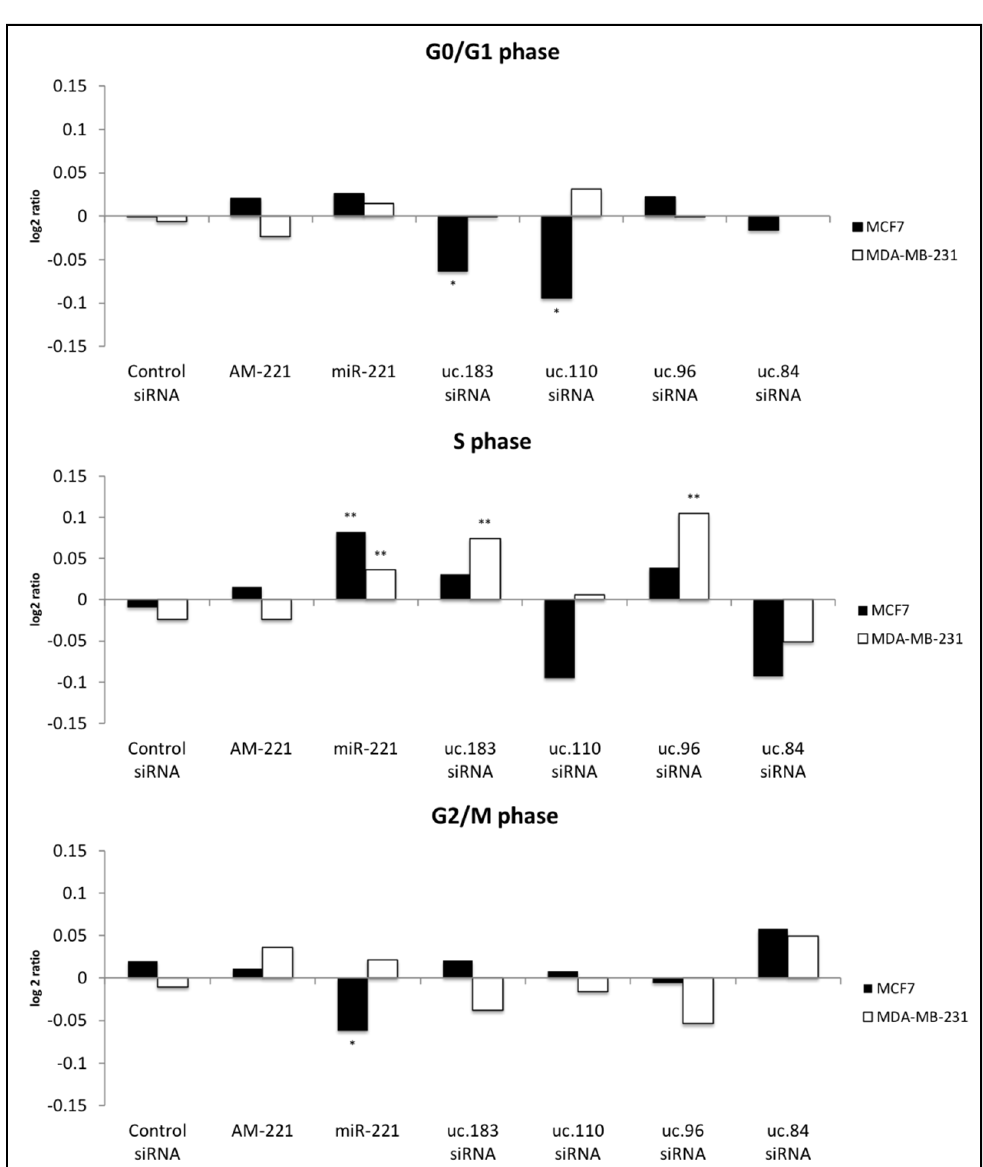
Figure 2. RNA interference of uc.84, uc.96, uc.110, and uc.183 on cell cycle in BC synchronized cell lines. Cell cycle was analyzed after transfections with siRNAs against the selected T-UCR, with miR-221 or anti-miR-221 (AM-221). Quantification was plotted as log2 ratio (median). Statistical significance was calculated, and the result compared to control random siRNA by 2-tailed Mann– Whitney test. p -values < 0.05 (*), p -values < 0.01 (**).